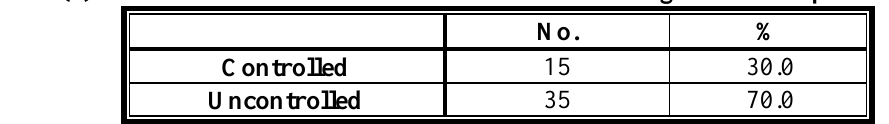
Distribution of the diabetic cases according to diabetic profile